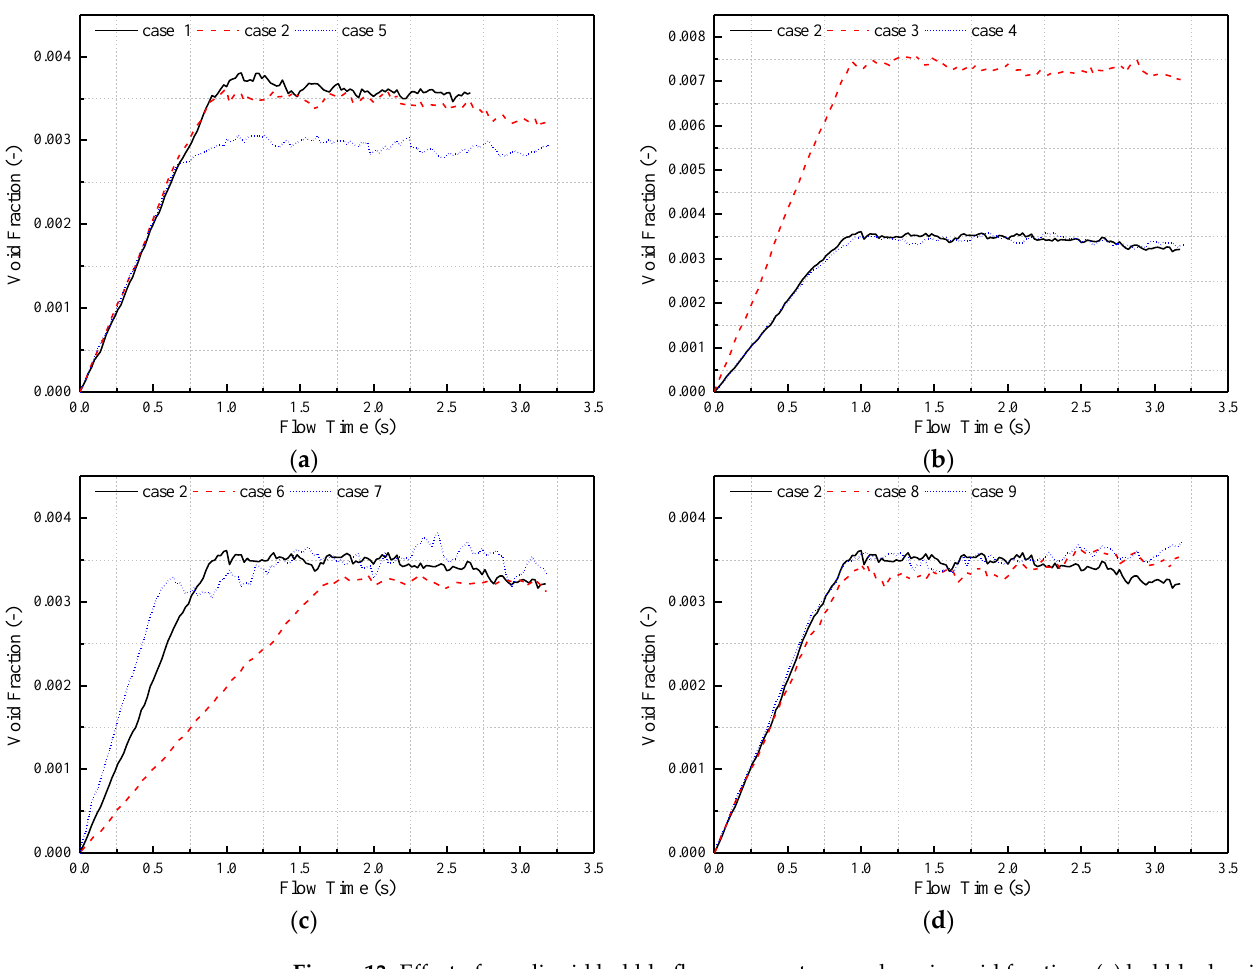
Figure 13. Effect of gas – liquid bubbly flow parameters on domain void fraction: ( a ) bubble density, ( b ) bubble diameter, ( c ) inlet velocity, and ( d ) bubble distribution.